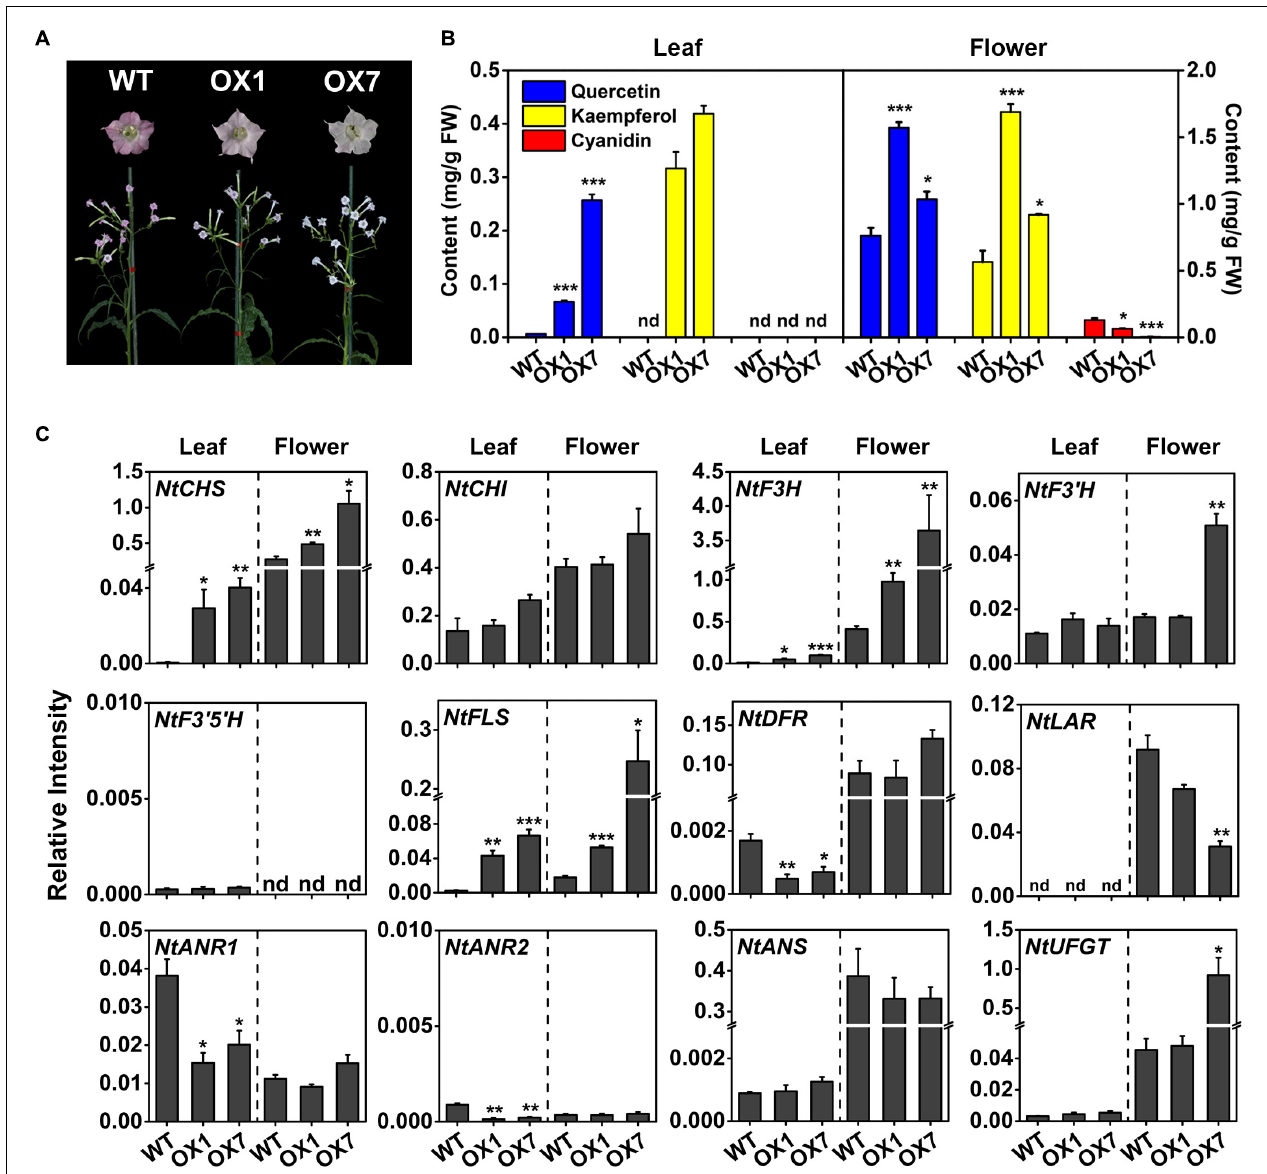
FIGURE 7 | Ectopic expression of MrMYB12 (F1) genes in tobacco. (A) Phenotypes of 35S:MrMYB12 transgenic and wild type (WT) tobacco flowers at the full bloom stage. (B) Flavonoid contents of transgenic and WT tobacco flowers and leaves. (C) Transcript levels of genes involved in flavonoid biosynthesis in tobacco leaves and flowers overexpressing MrMYB12 (F1). OX1 and OX7 represent line 1 and line 7 of T1 transgenic plants overexpressing 35S:MrMYB12 (F1), respectively. Student’s t -test was used for statistical analyses compared with WT (* P < 0.05, ** P < 0.01, and *** P < 0.001). Error bars indicate SEs from three replicates. FW, fresh weight; ND, not